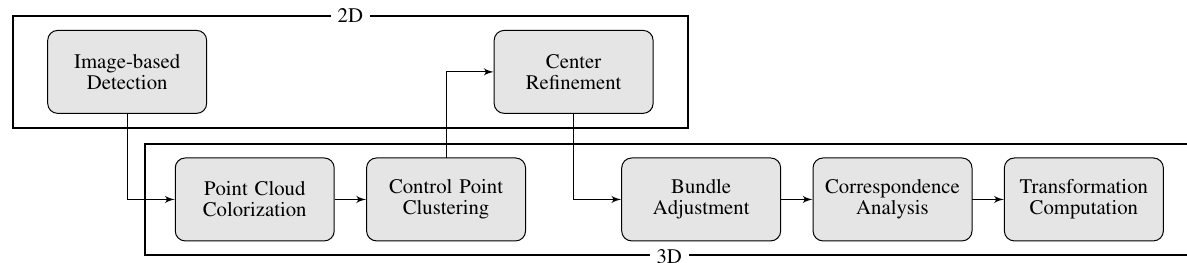
Figure 3. Schematic workflow of control point detection, refinement, correspondence analysis, and transformation computation.